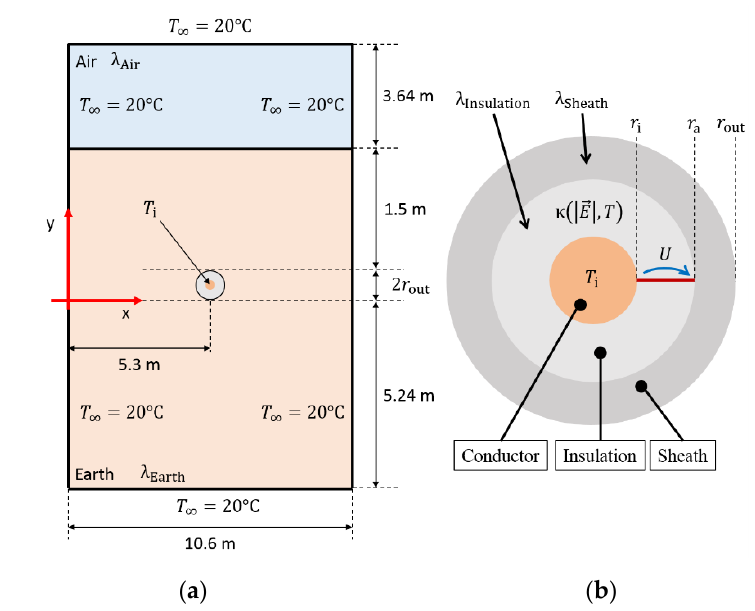
Figure 11. ( a ) Two-dimensional geometry of a single cable within the earth; ( b ) the cable consists of conductor, insulating material and outer sheath [51]. conductor, insulating material and outer sheath